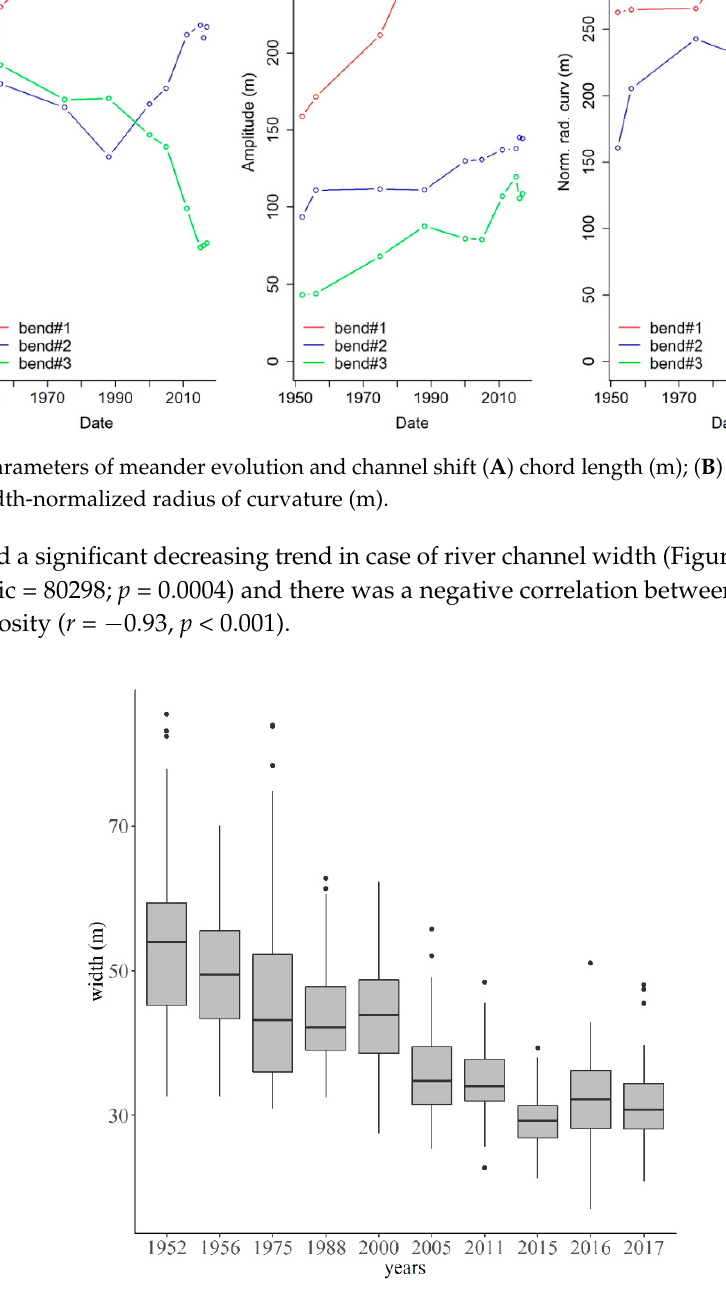
Figure 7. Changes in the mean channel width.